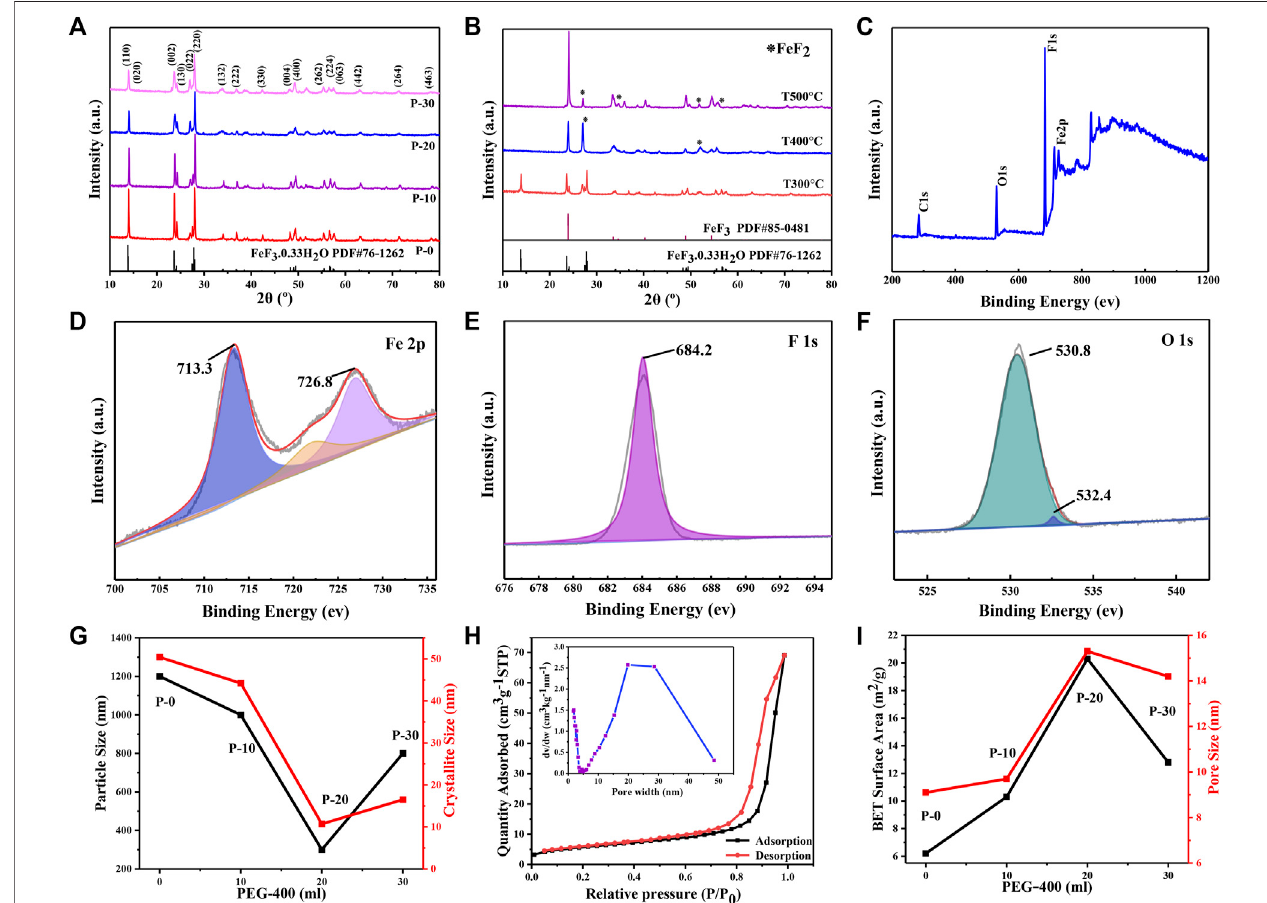
FIGURE3|(A) XRDpatternsofFeF 3 · 0.33H 2 O. (B) XRDpatternsofFeF 3 · 0.33H 2 O(P-20)atvarioustemperatures.XPSspectraofFeF 3 · 0.33H 2 O(P-20): (C) thefull- spectrum, (D) Fe2p, (E) F1s,and (F) O1s. (G) ThevariationsofparticleandcrystallitesizeofFeF 3 · 0.33H 2 OunderdifferentPEGvolumes. (H) Nitrogensorptionisotherms of FeF 3 · 0.33H 2 O (P-20); inset: the correspondingporediameter distribution curves. (I) The variations ofBET surface area and pore size of FeF 3 · 0.33H 2 O under different PEG